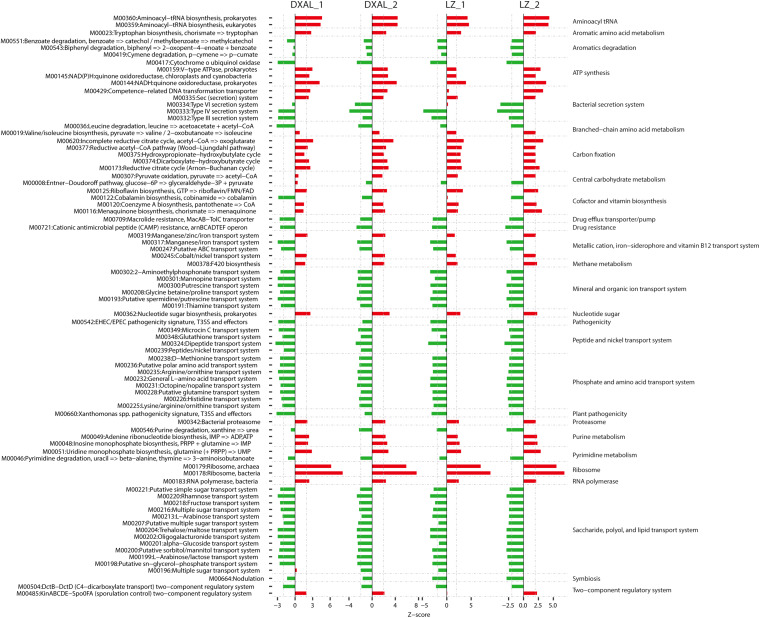
Alterations in bacteria microbial functional modules in each compare group. Dashed lines indicate a reporter score of 1.96, corresponding to 95% confidence in a normal distribution. DXAL_1: DXAL_1_Root vs. DXAL_1_Soil, DXAL_2: DXAL_2_Root vs. DXAL_2_Soil, LZ_1: LZ_1_Root vs. LZ_1_Soil, LZ_2: LZ_2_Root vs. LZ_2_Soil. DXAL: Greater Khingan Mountains, LZ: Linzhi, 1: vegetative growth stage, 2: reproductive growth stage.